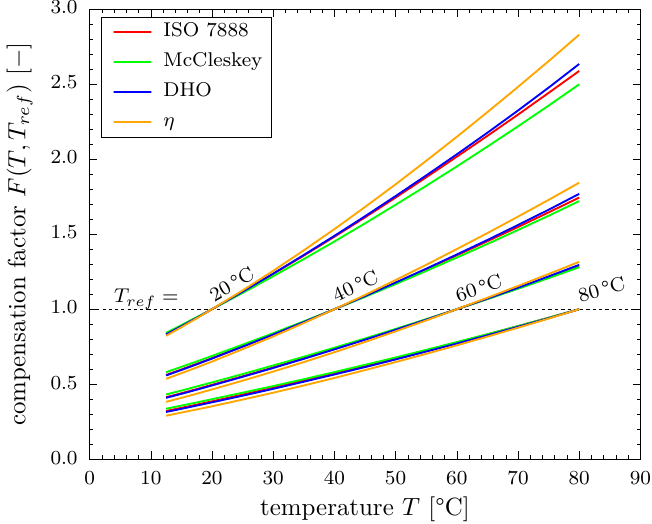
Figure 4. Comparison of modeled compensation factors at four different reference